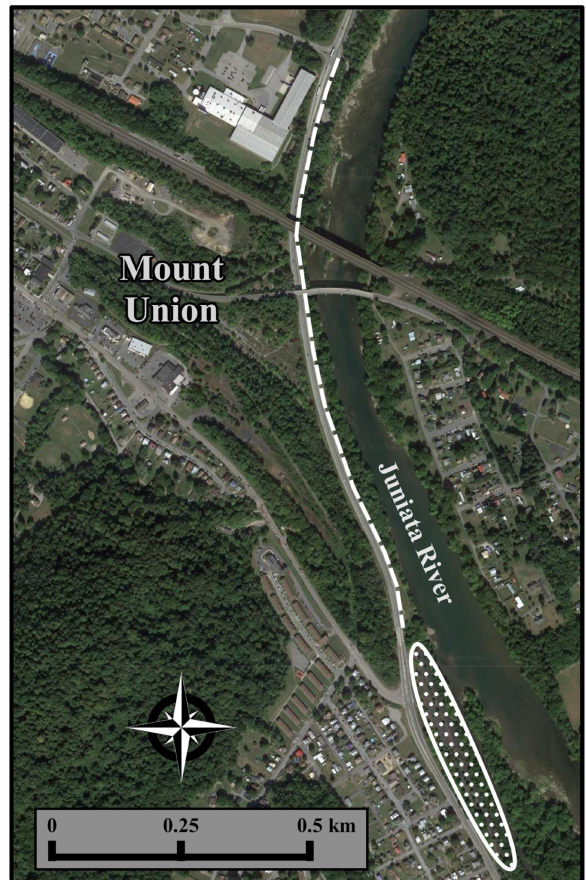
Figure 1. Map of our study site for Northern Map Turtles along the Juniata River at Mount Union, Pennsylvania. The white dashed line indicates the turtle exclusion fence adjacent to the highway, which forms the western border of the linear mitigation area of nesting habitat. The area to the south with a dotted interior is the coal tailings